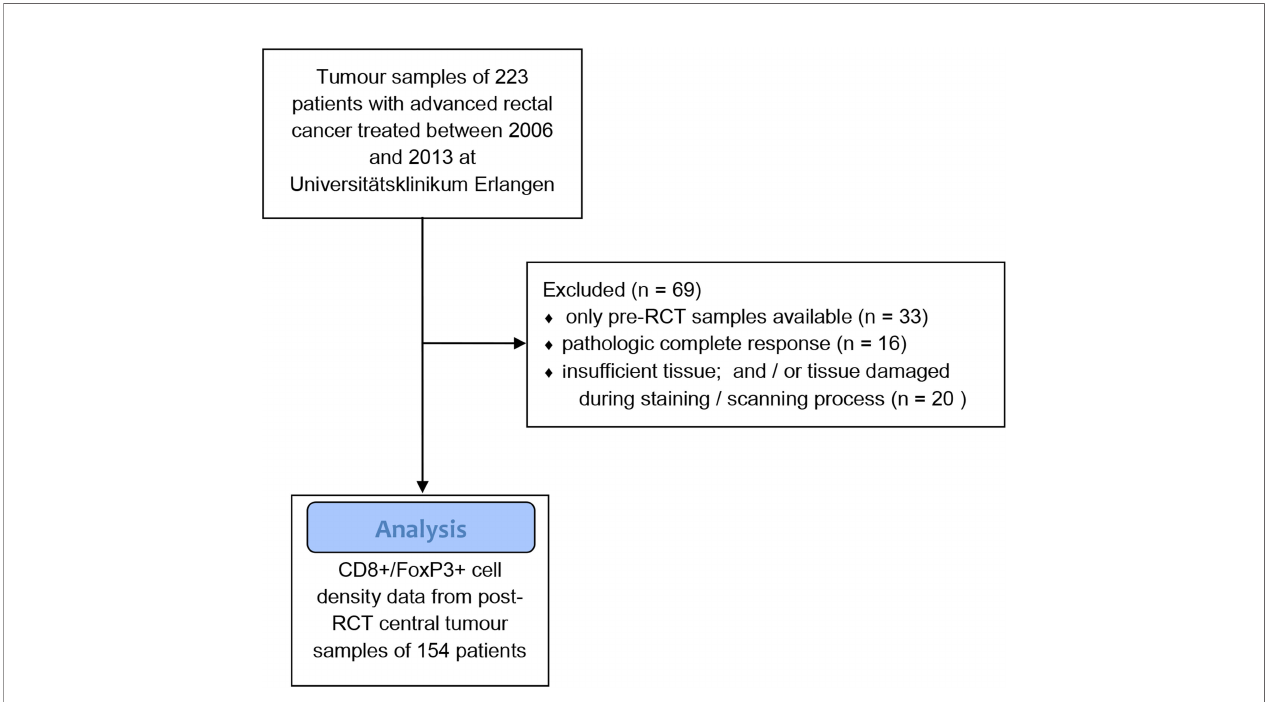
FIGURE 1 | Flow diagram of the patient and tissue sample selection